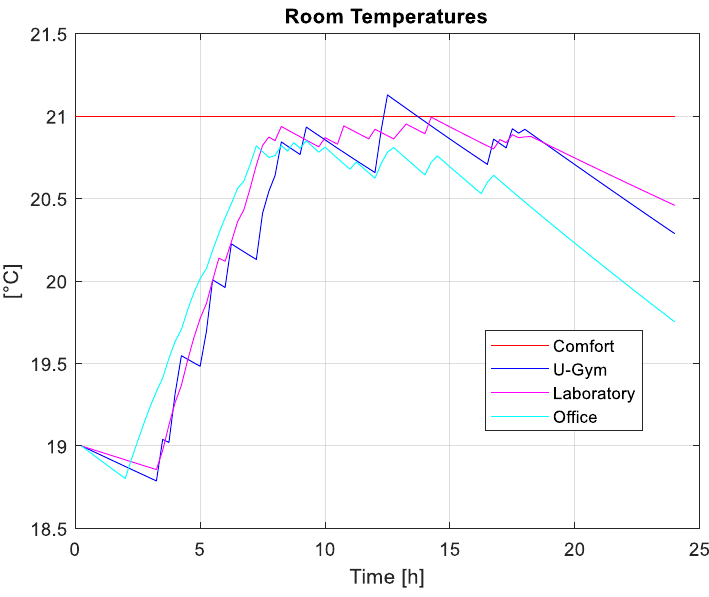
Figure 16. Room temperature profiles in the case of comfort temperature tracking and energy consumption minimization.